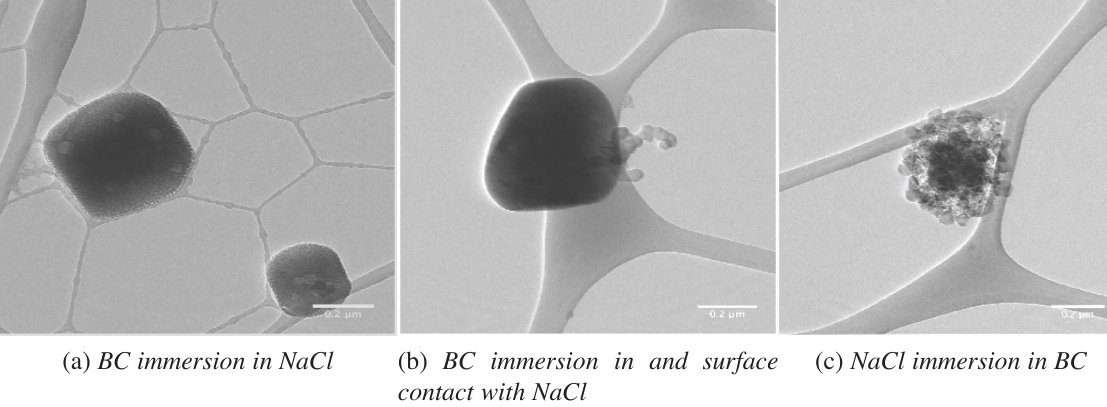
(a) BC immersion in NaCl (b) BC immersion in and surface (c) NaCl immersion in BC contact with NaCl Fig. 4. TEM images of BC (lighter grey) mixed with NaCl (darker grey): (a) total inclusion of BC in NaCl, (b) partial inclusion and partial Fig. 4: TEM images of BC (lighter grey) mixed with NaCl (darker grey): a) total inclusion of BC in NaCl , b) surface contact of BC in NaCl, and (c) total inclusion of NaCl in BC. partial inclusion and partial surface contact of BC in NaCl, and c) total inclusion of NaCl in BC. Table 2. Characteristics of the modeled bare BC and mixtures of BC and NaCl and optical properties predicted by DDSCAT. The core BC has 70 monomers with diameter of